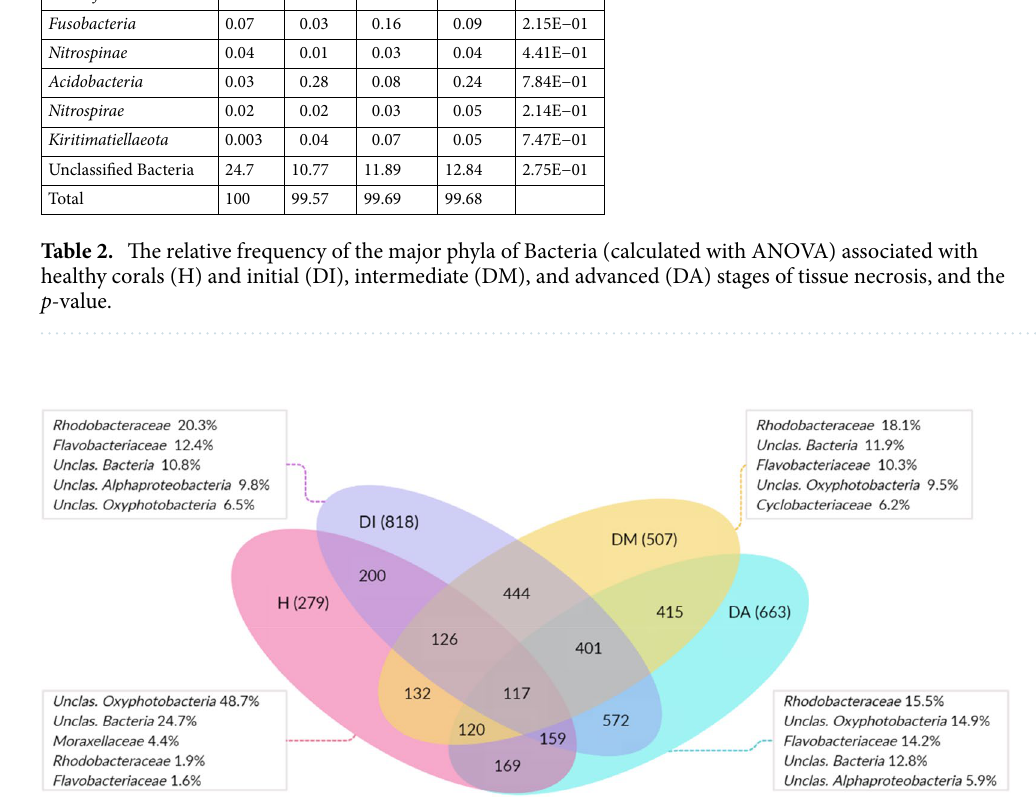
Figure 4. Venn diagram showing the microbiota (OTUs) of each analyzed stage, of which pink represents healthy colonies (H), purple initial necrosis stage (DI), yellow for colonies in the intermediate necrosis stage (DM), and blue represent colonies in the advanced stage (DA). The numbers of shared OTUs between stages are shown in the intersections. Within the boxes are the five most abundant classifications at the family level for each corresponding